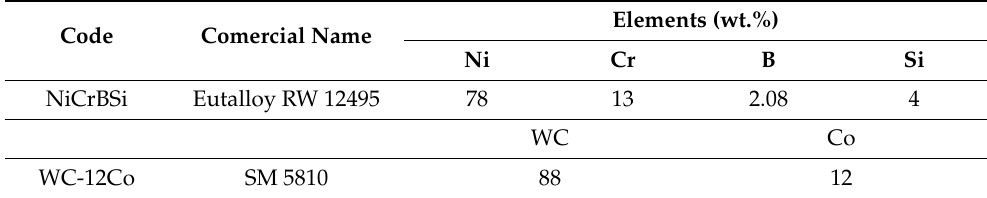
Figure 1. Powders used herein: ( a ) NiCrBSi, ( b ) NiCrBSi + 30 wt.% WC-12Co and ( c ) WC-12Co. Table 1. Chemical compositions of feedstock